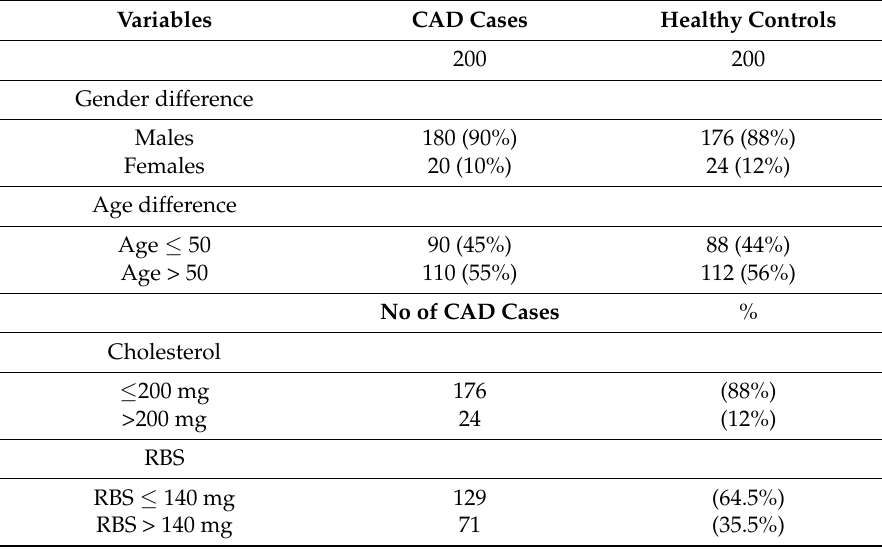
Table 3. Baseline characteristics of CAD patients and